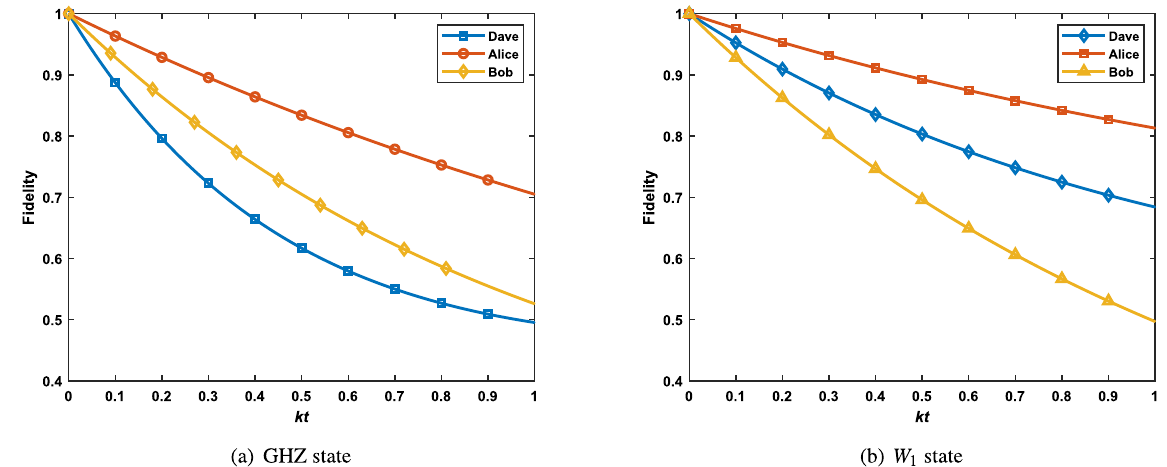
Figure 5. The fidelities of quantum teleportation of the initial states are prepared by Alice, Bob and Dave,